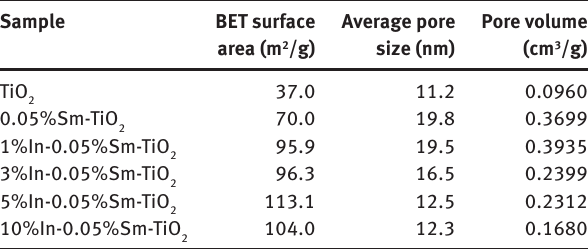
Table 2: Specific surface area and pore structure of x In-0.05%Sm-TiO 2